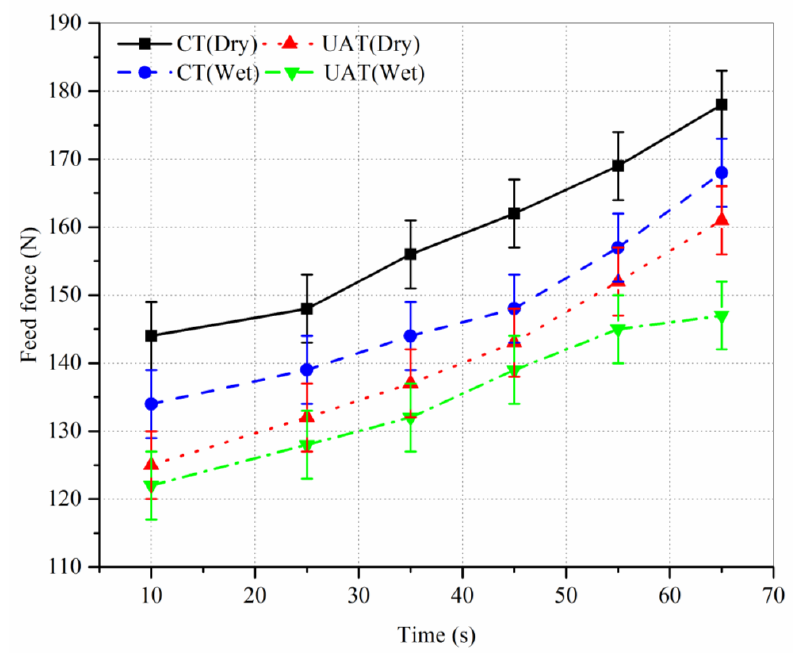
Figure 3. Variation in feed force with time in CT and UAT under dry and wet conditions ( 𝑉 = 50 m/min, 𝑓 = 0.2 mm/rev, 𝑎 = 0.4 mm).